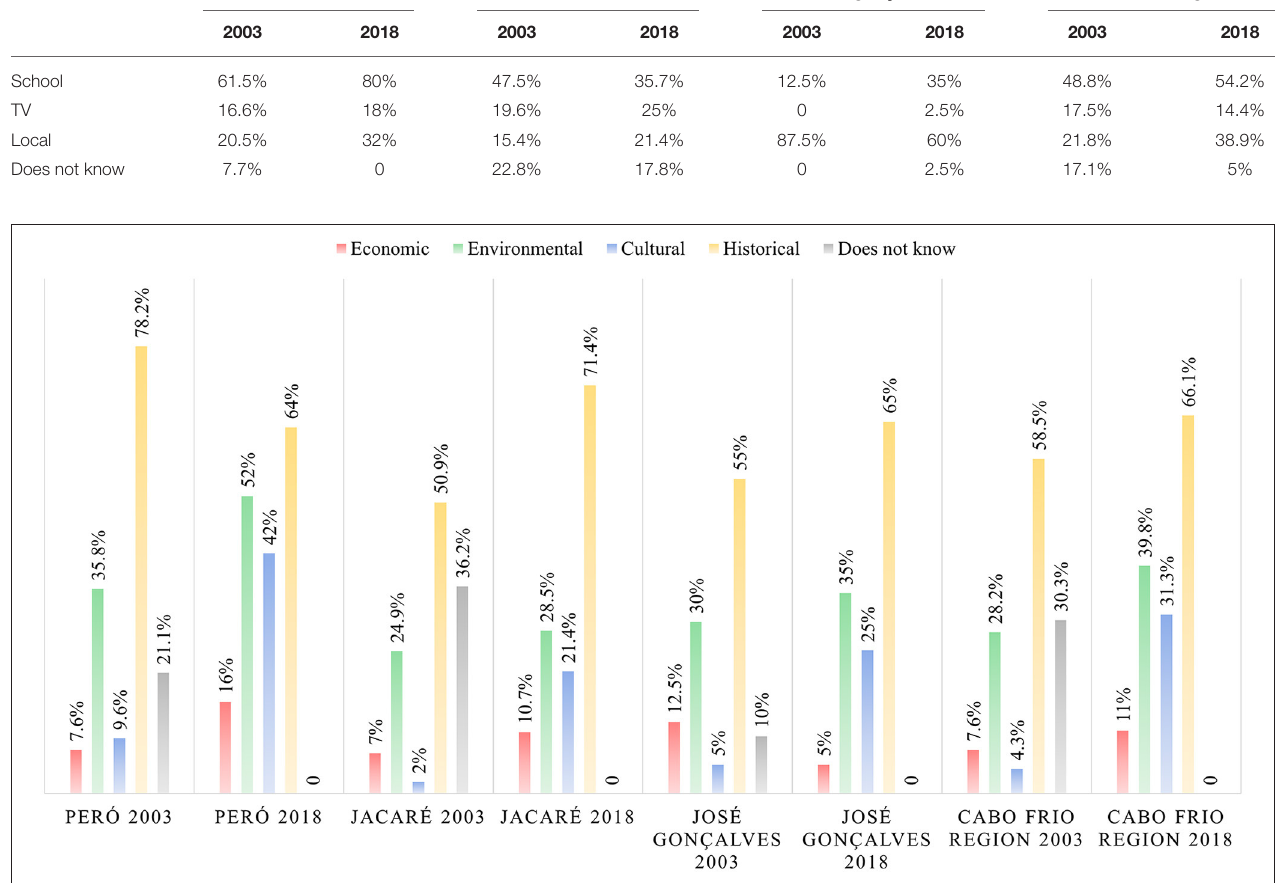
FIGURE 5 | Diachronic analysis comparing the changes in brazilwood importance perception between Cabo Frio region residents over 15